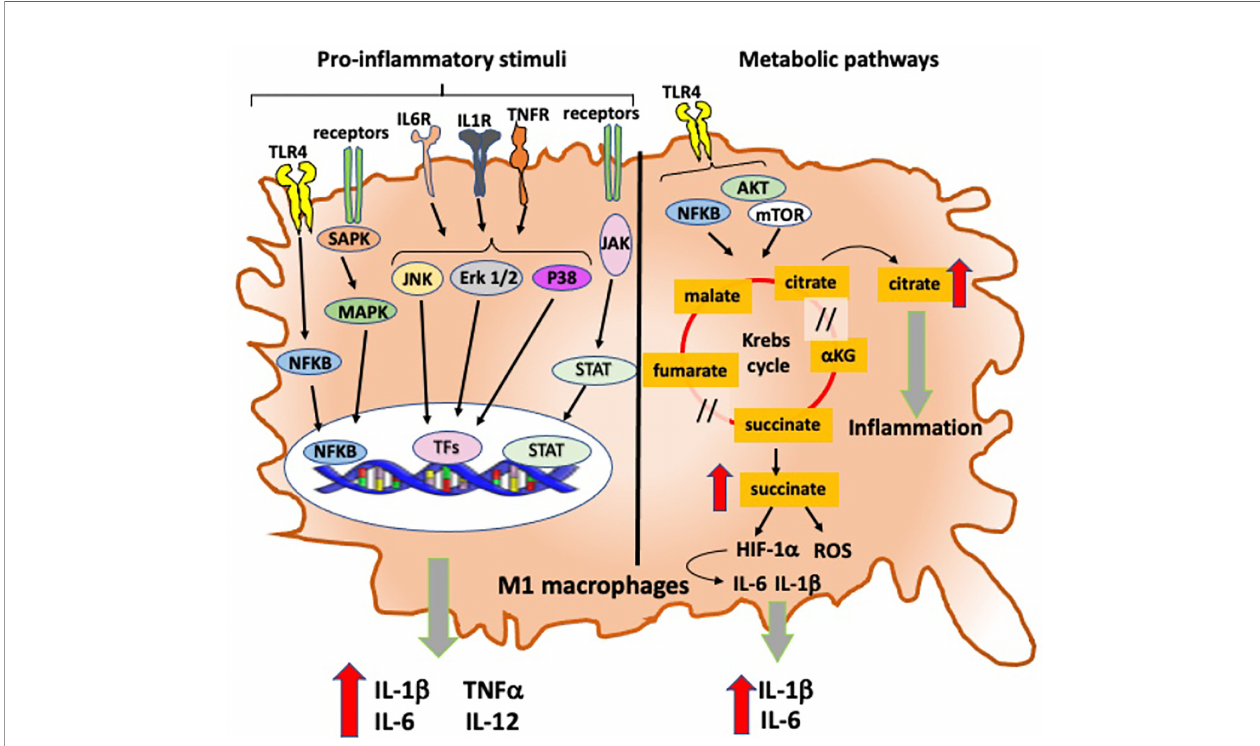
FIGURE 4 | Intracellular signaling and metabolic pathways activated into RA pro-in fl ammatory M1 macrophages. Intracellular signaling and metabolic pathways activated in M1 macrophages that contribute to their pro-in fl ammatory role in the in fl ammatory process in RA. TLR4, Toll-like receptor 4; IL-6R, interleukine-6 receptor; IL-1 b R, interleukine-1 b receptor; TNFR, tumor necrosis factor receptor; NFkB, nuclear factor-kB; SAPK: stress-activated protein kinases; MAPK, mitogen- activated protein kinases; JAK, Janus kinase; STAT, signal transducer and activators of transcription; Erk1/2, extracellular signal-regulated protein kinases 1 and 2; JNK, Jun N-terminal kinase; TFs, transcription factors; AKT, protein kinase B; mTOR, mechanistic target of rapamycin; HIF-1 a , hypoxia-inducible factor-1 a ; ROS, reactive oxygen species; /, break in Krebs